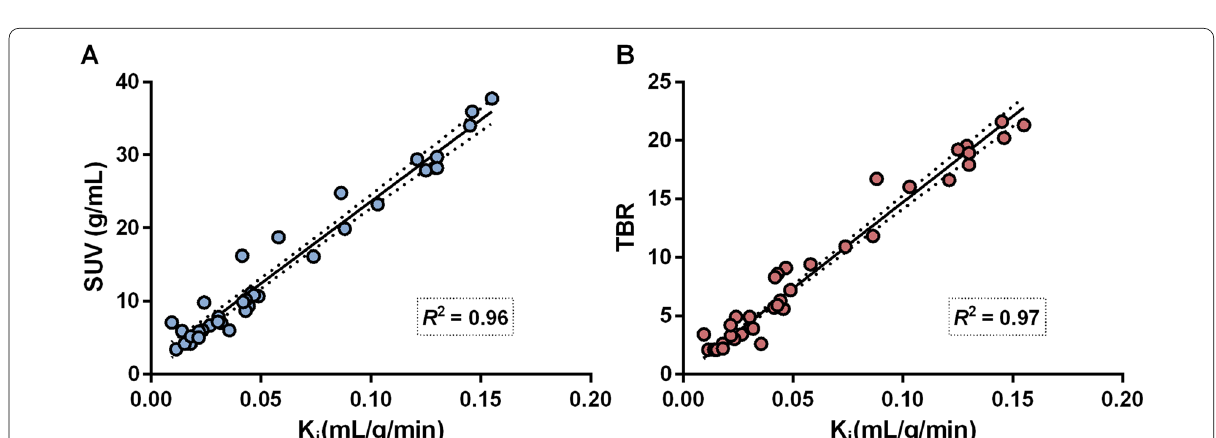
Fig. 6 Correlation between ( A ) tumor K i and tumor SUV and between ( B ) tumor K i and tumor‑to‑blood ratio (TBR) during all three dynamic scans. Solid line represents linear regression fits and dashed lines are 95% confidence band of these fits. R 2 represents the square of Pearson